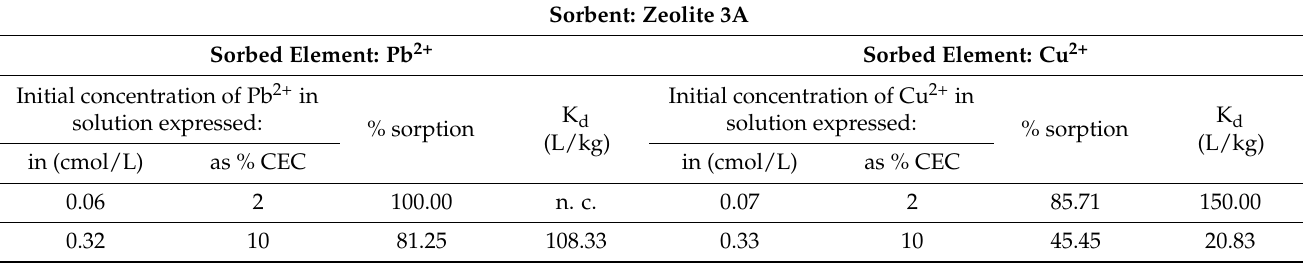
Table 3. The results of the examination of sorption of Pb 2+ and Cu 2+ onto tested synthetic zeolites—% sorption and K d